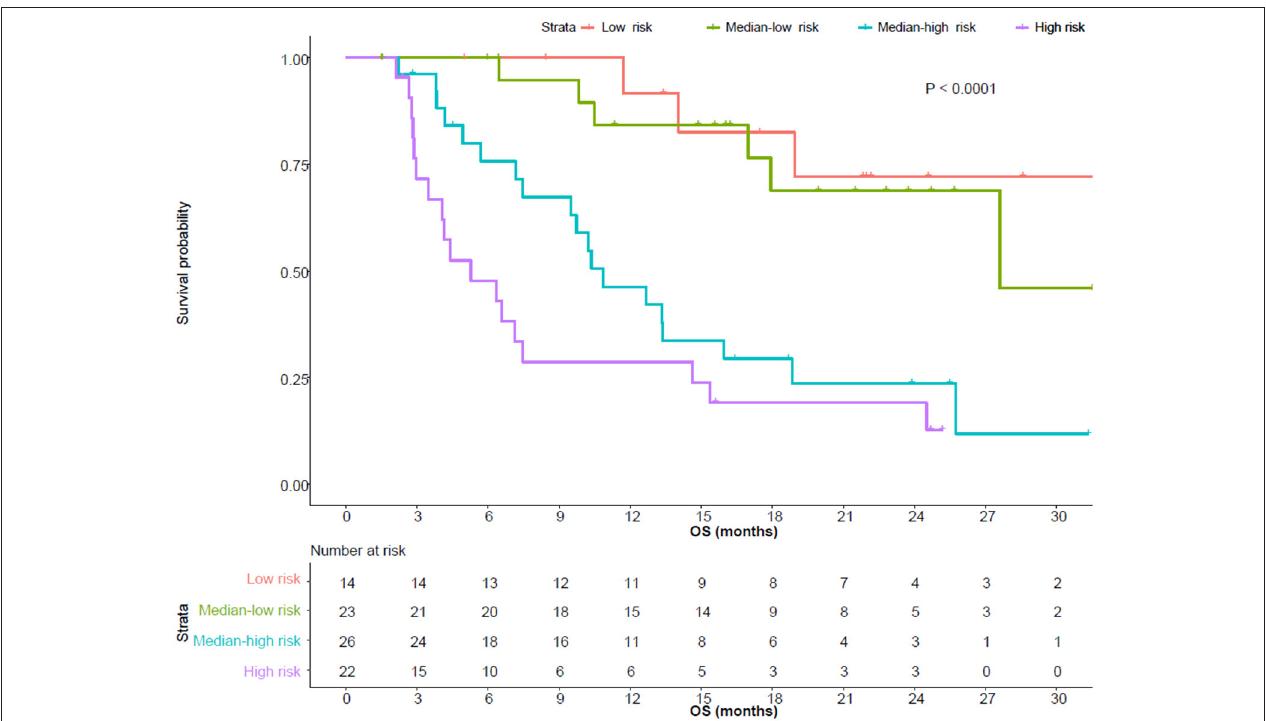
FIGURE 2 | Overall survival (OS) of patients with different risks. The median OS of patients with low, median-low, median-high, and high risks was not reached (95% CI, 18.9-not reached), 27.6 (95% CI, 17.9-not reached), 10.9 (95% CI, 9.5-not reached) and 5.3 (95% CI, 3.5–15.4) months, respectively.